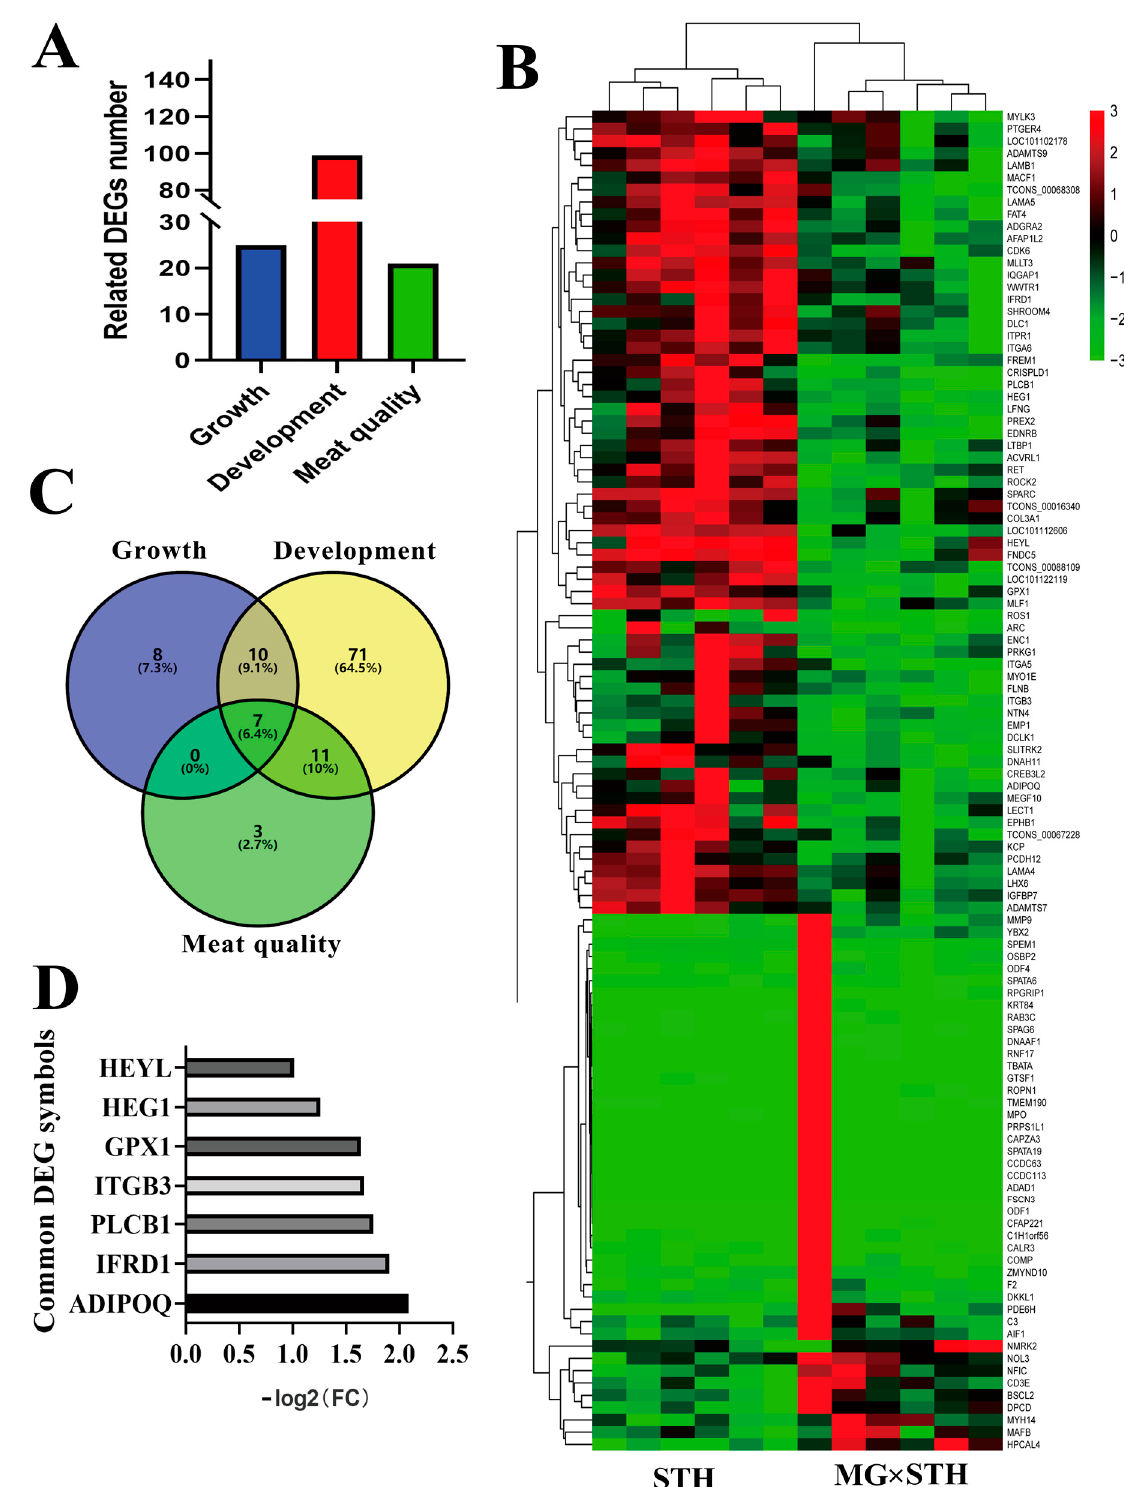
Figure 3. Identification of candidate DEGs related to production performance and meat quality in the MG × STH and STH sheep. ( A ) Identification of the candidate DEGs related to growth and development in the two sheep groups. ( B ) A heatmap of the DEGs related to growth, development, and meat quality in each group. ( C ) A Venn diagram of DEGs related to growth, development, and meat quality. ( D ) The common DEGs involved in growth, development, and meat quality and their relative expression using a transcriptomic analysis. The x axis represents the relative expression by − log 2 (Fold Change).